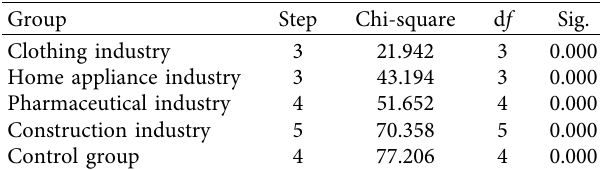
Table 11: Omnibus tests for the model coefcients.